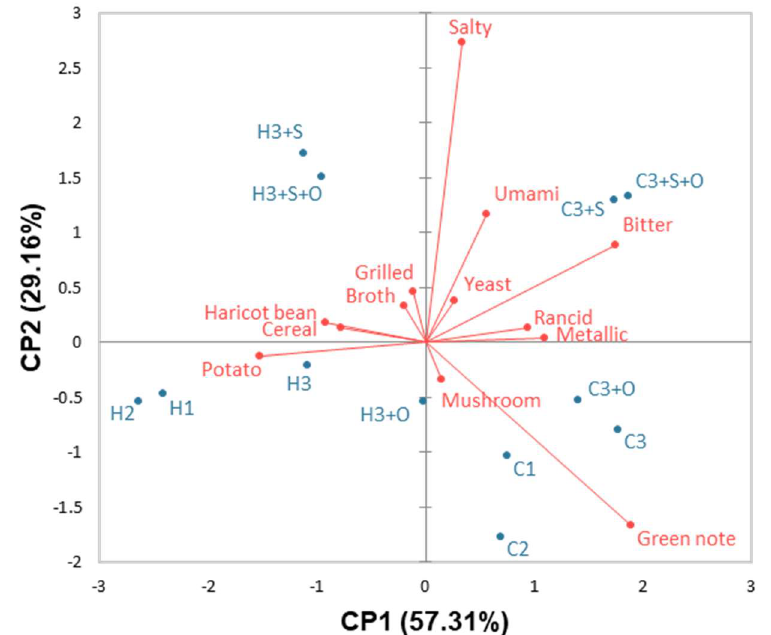
Figure 2. Biplot representation of the PCA (covariance) of the taste and aroma sensory descriptors of the 12 gels defined in Table 1. Table 5. Results of ANOVA (panellist + cultivar + heat treatment + cultivar*heat treatment) to examine the taste/aroma descriptor intensities and liking score of 6 gels (C1, C2, C3, H1, H2 and H3) (Table 1). Significant p -values are in bold (α = 0.05).